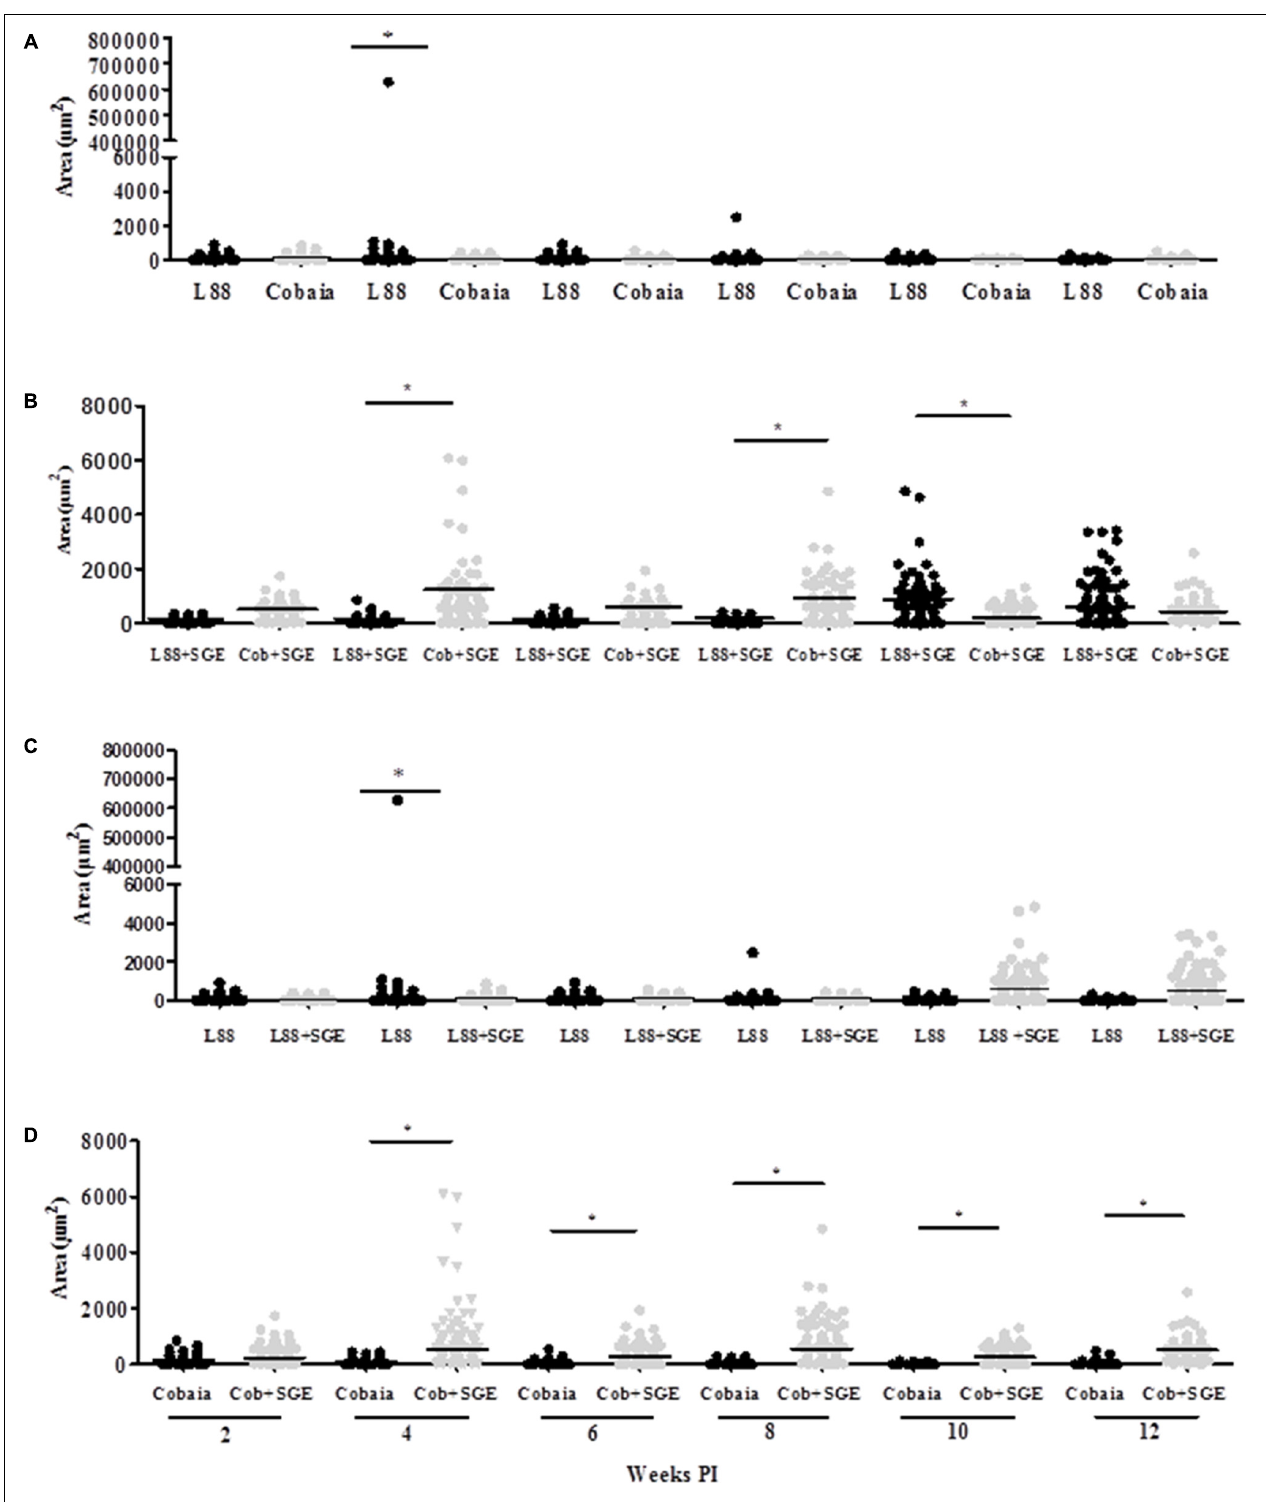
FIGURE 9 | Morphometric analysis ( µ m 2 ) of the immunohistochemistry (IHC) of C. porcellus infected with L. enriettii (L88 and Cobaia) strains in the absence/presence of salivary gland extract (SGE). Areas of CD163 positive cells staining in L88 versus Cobaia strains in the absence (A) or presence (B) of SGE. L88 (C) and Cobaia (D) strains in the absence/presence of SGE at 2, 4, 6, 8, 10 and 12 weeks PI. Asterisks indicate statistical significance between groups at p < 0.05.